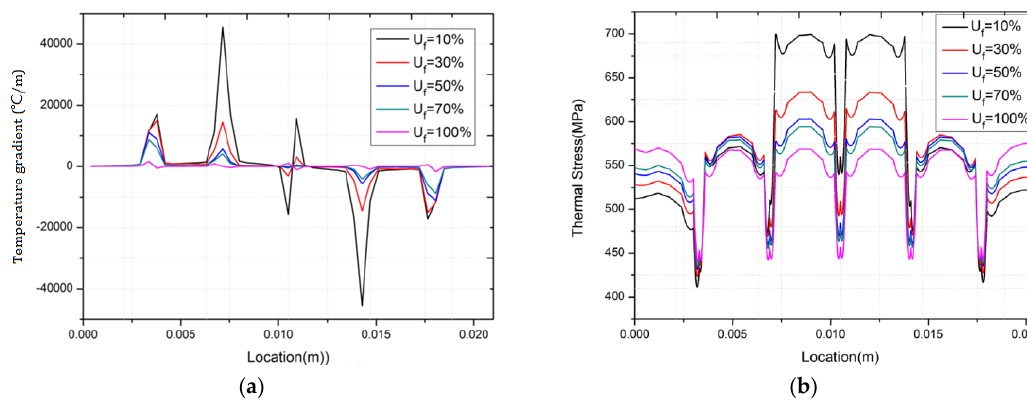
Figure 16. Temperature gradient and thermal stress distributions along Line 2 (P = 13.23 W). ( a ) Temperature gradient distribution; ( b ) Thermal stress distribution.